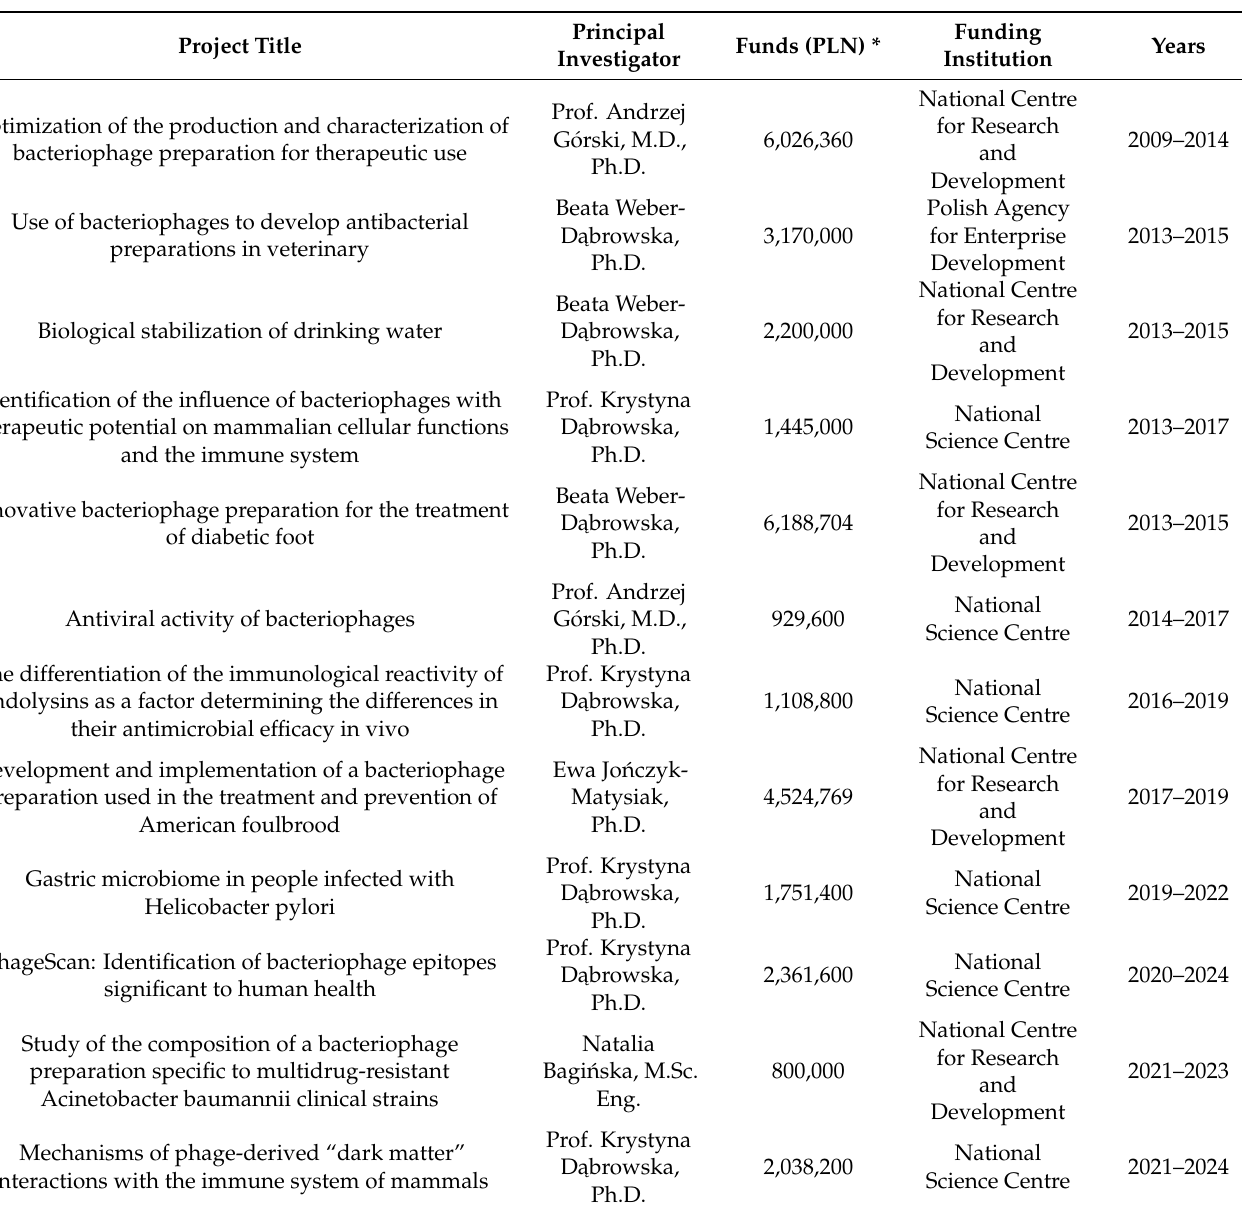
Table 7. Chronological list of the most funded phage projects conducted at phage-related units of the Hirszfeld Institute since